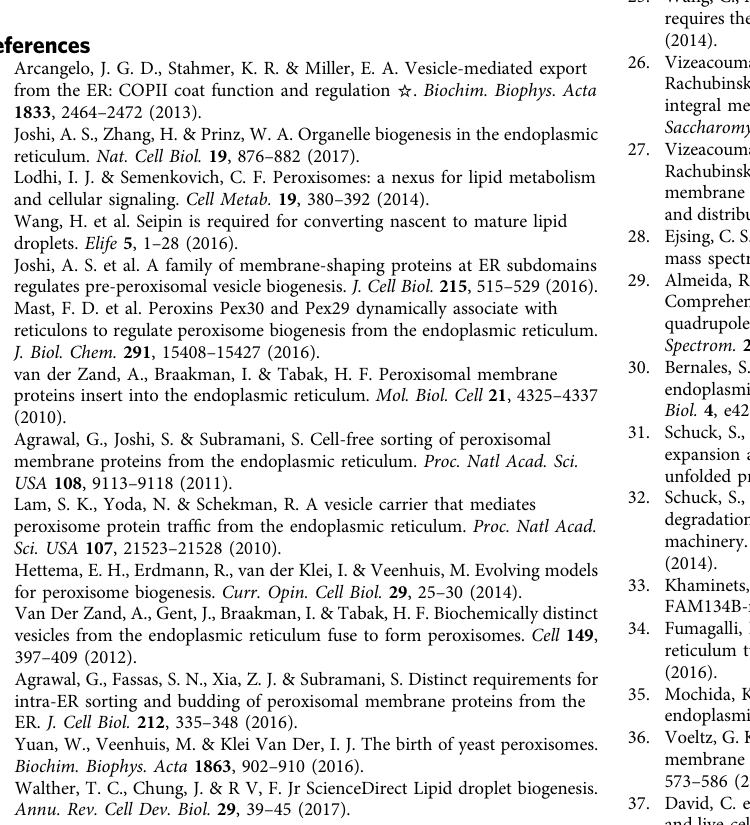
lipid species were identi fi ed and quanti fi ed using Lipid Pro fi ler (MDS Analytical Technologies) and proprietary Analysis of Lipid EXperiments (ALEX) software. Statistical analysis . Data for all microscopy experiments were generated from at least two independent experiments. For each experiment, 150 cells were scored per condition and/or genotype from multiple microscopy fi elds. Distributions are presented as mean±SD. Where indicated, the volume of dispersed bodipy struc- tures was measured using the 3iSlidebook 6.0 software and statistical signi fi cance tested using the Mann – Whitney test in GraphPad Prism 7. Two-tailed P -values are indicated in fi gures where relevant. Proteomics data result from analysis of six (for WT and ldb16 Δ ) and two (for fl d1 Δ ) independent LD isolation experiments. Lipidomics data result from two independent biological replicates for all genotypes, each analyzed in two independent technical replicates. In all experiments, cells were randomly selected for analysis and no samples were excluded.